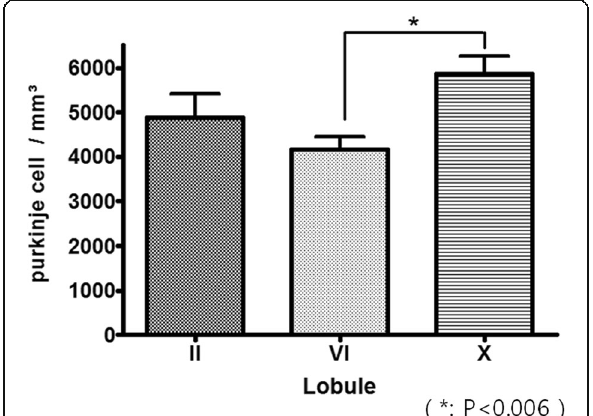
Fig. 4 Purkinje cell density according to lobules. Counting frame size is 5.7 μ m × 2.8 μ m. (*: p <